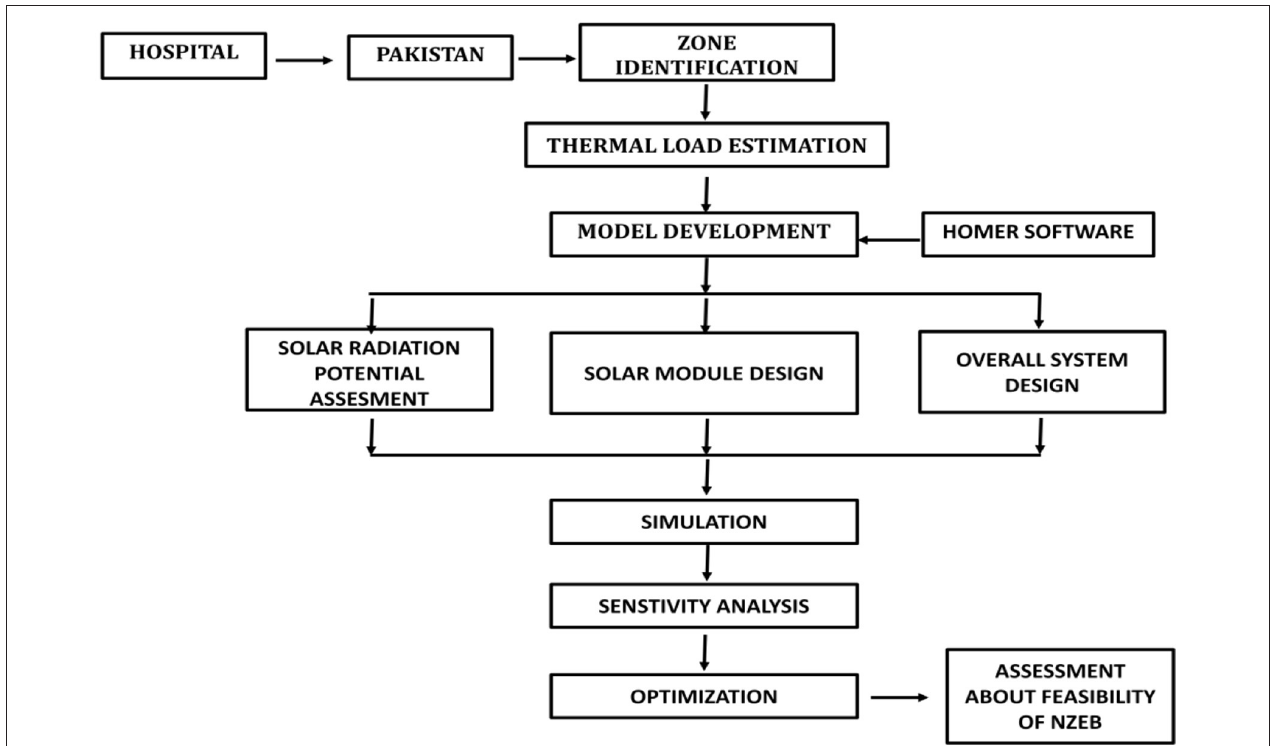
FIGURE 1 | Methodology of the